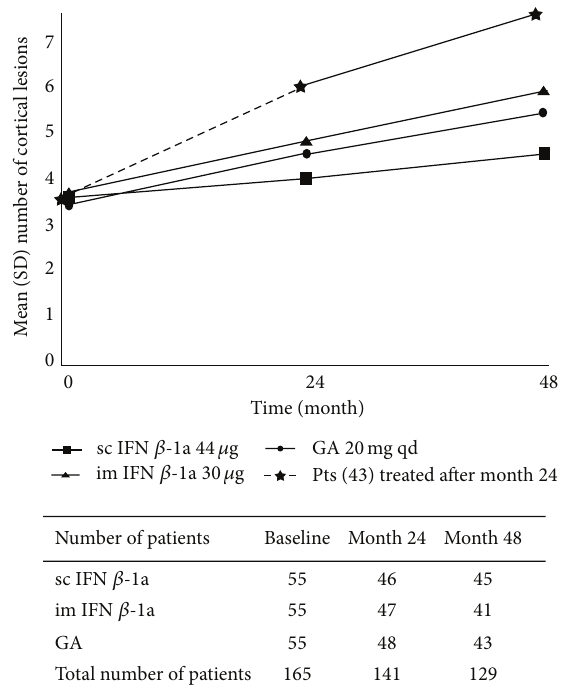
Figure 2: Mean number of total cortical lesions at baseline and at